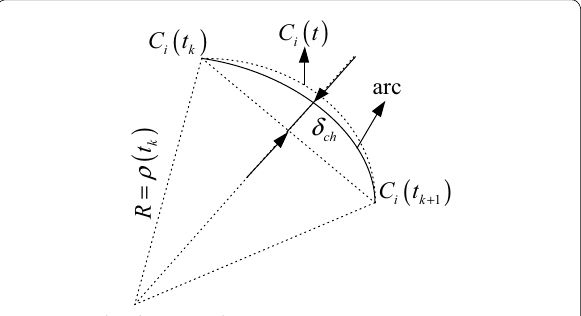
Figure 5 Chord error on the Bézier